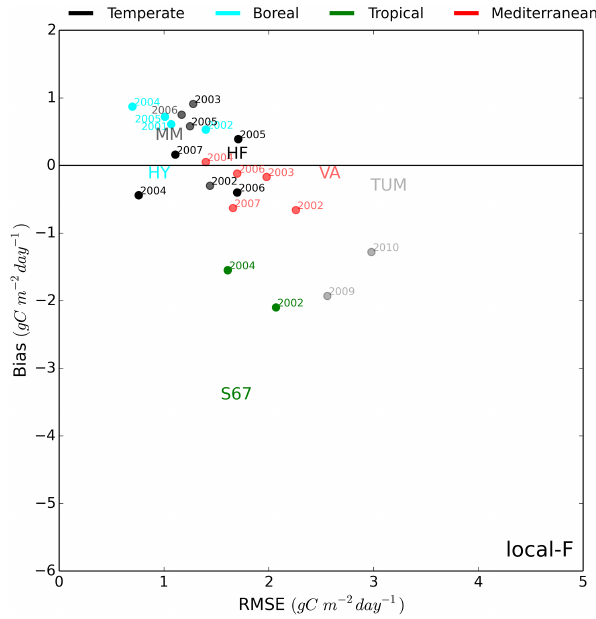
Figure 3. Multi-year comparison of modelled and observed GPP using bias and RMSE at six FLUXNET sites (HF: Harvard For- est; VA: Vaira Ranch; MM: Morgan Monroe; HY: Hyytiala; TUM: Tumbarumba; S67: Santarem Km67) for model simulations using local parameter and meteorological data (local-F). The site labels are coloured according to their climate zone (Table 2) and repre- sent data from model simulations performed for the year specified in Table 2, with results from other years plotted using the model simulation year and labels coloured the same as the original site